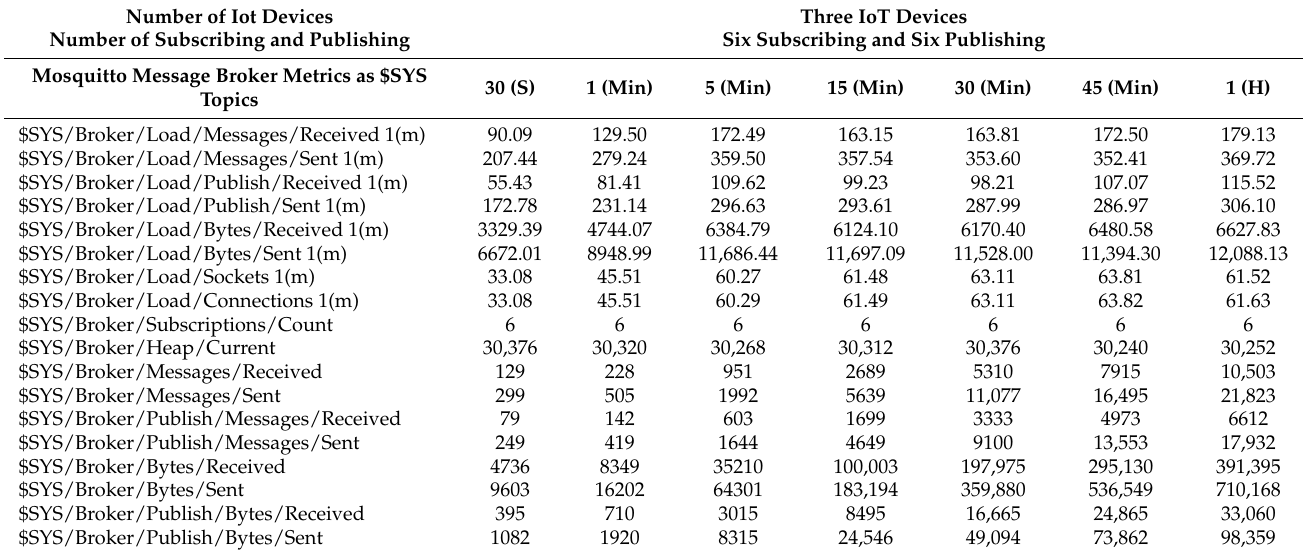
Table 6. Mosquitto message broker metrics on the fog layer using a bridge—first architecture. Number of Iot Devices